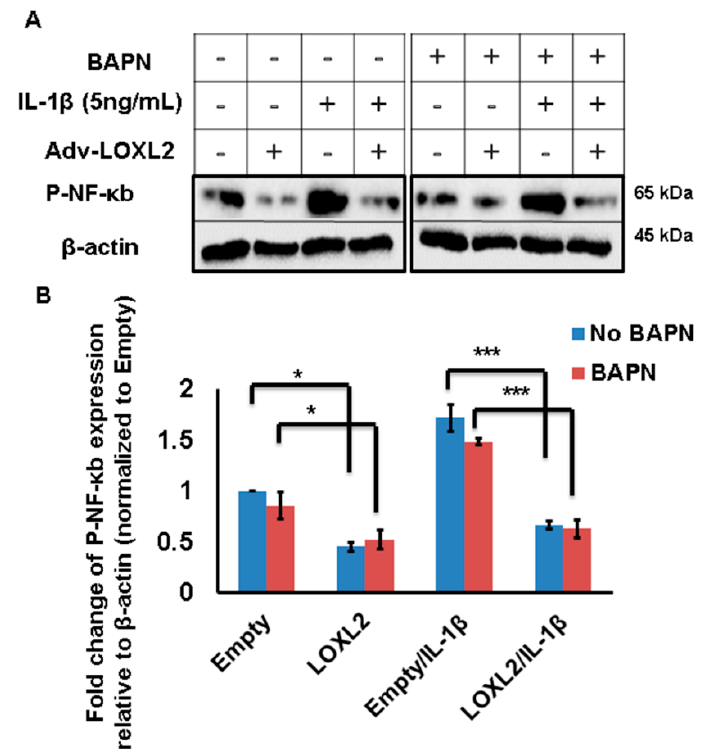
Figure 4. LOXL2 protects against IL-1 β -induced NF- κ B signaling even in the presence of a LOX family inhibitor. ( A ) IL-1 β promotes phospho-NF- κ B in ATDC5 cells, and this effect is attenuated by LOXL2 overexpression in the absence or presence of BAPN. The minus ( − ) sign represents absence wheras